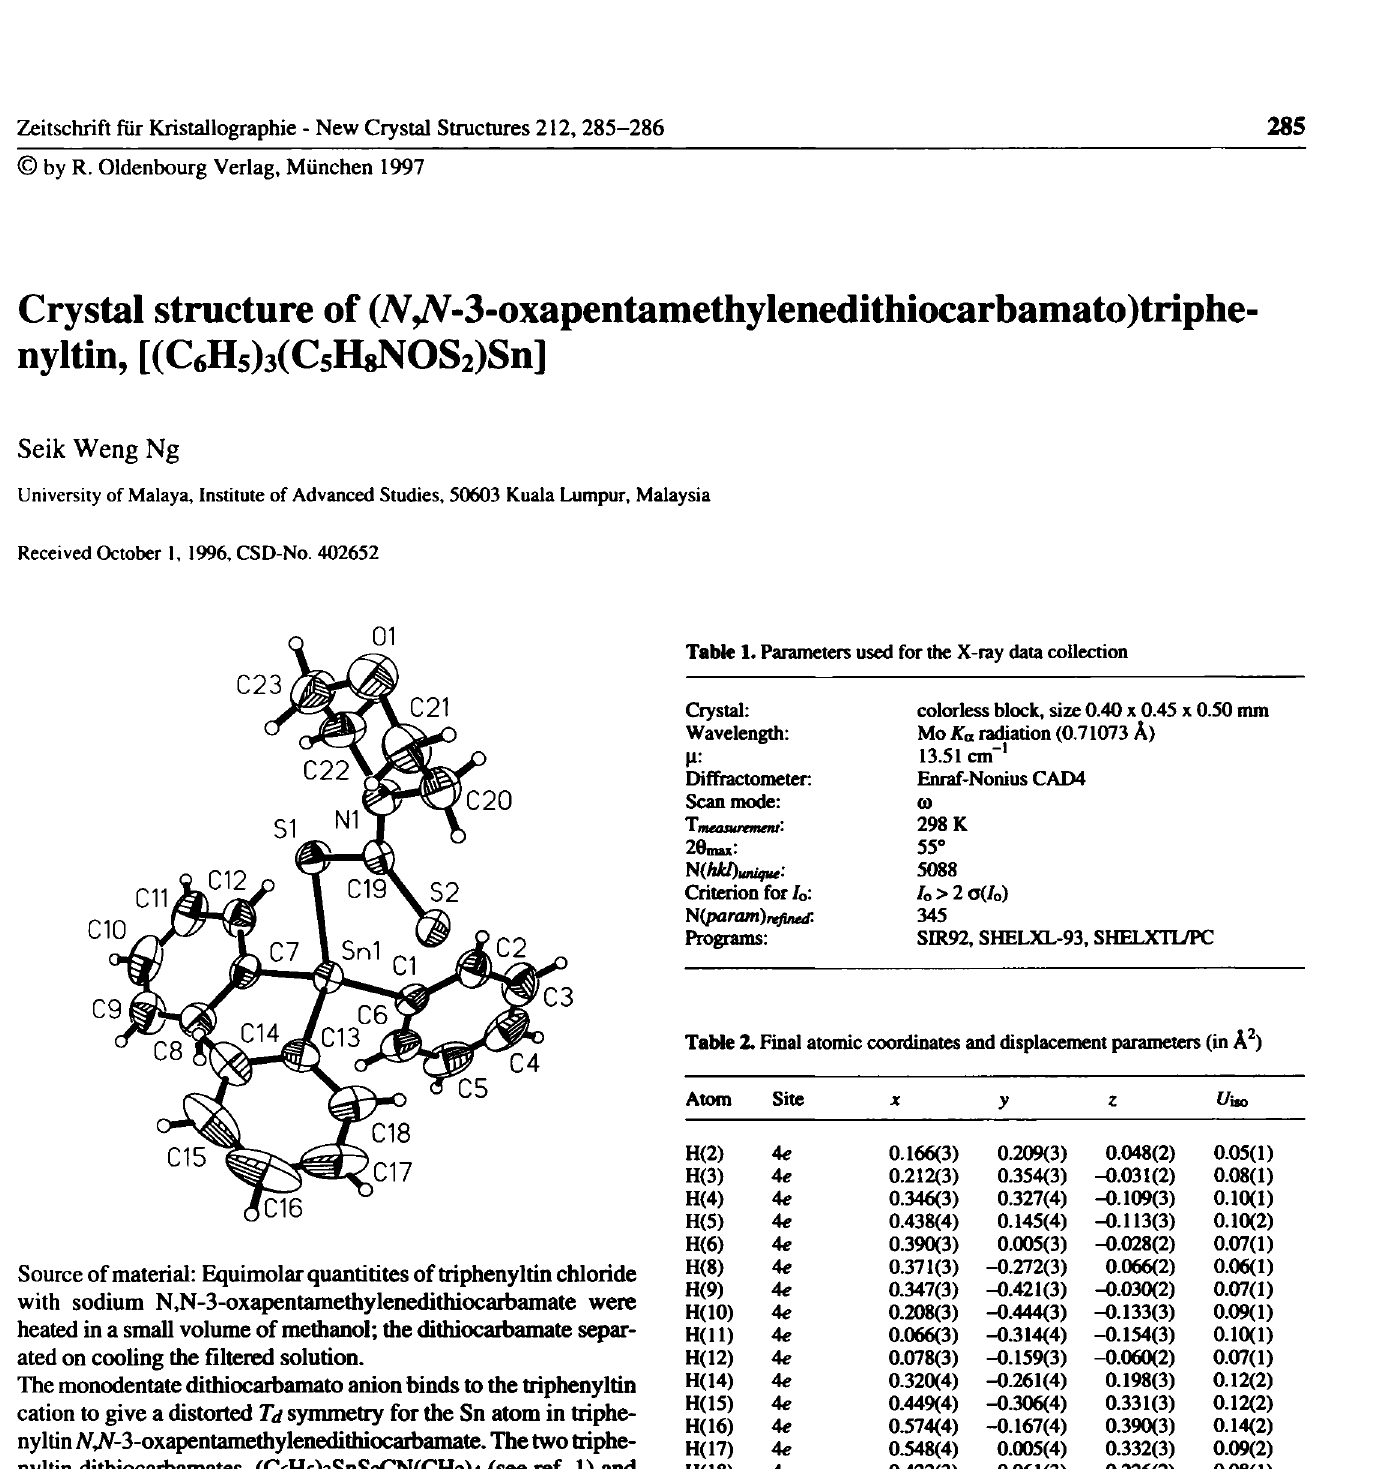
Table 2. Final atomic coordinates and displacement parameters (in Â 2